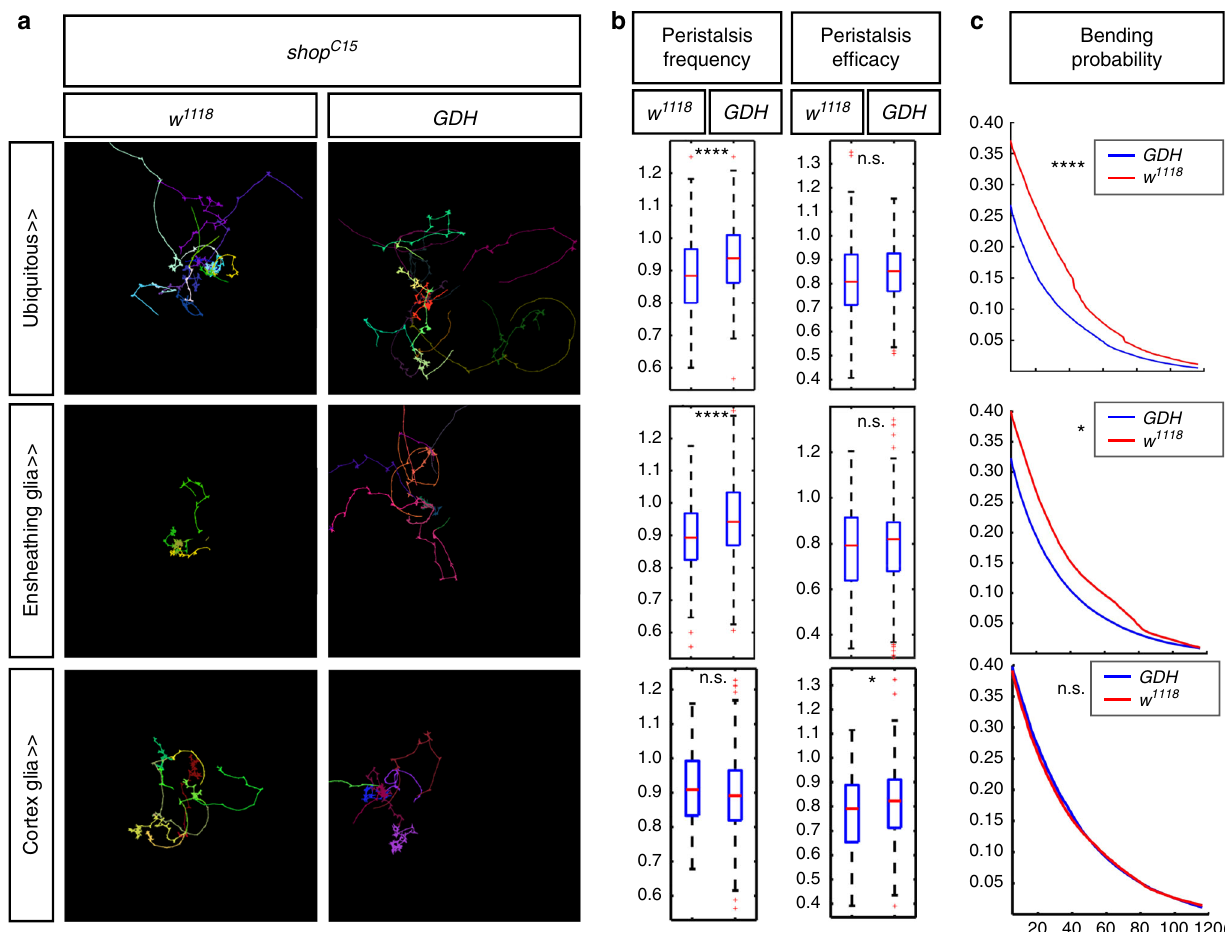
Fig. 7 Increased Gdh expression suppresses the shopper mutant phenotype. a Locomotion trajectories of third-instar larvae mutant for shopper ( shop C15 ) expressing Gdh ( Gdh ), either by presence of the ubiquitous driver ( da-Gal4 ), an ensheathing glia-speci fi c driver ( R83E12-Gal4 ), or a cortex glia-speci fi c driver ( R55B12-Gal4 ) (on the right) are compared to controls that contain the mutation as well as drivers but no Gdh expression transgene ( w 1118 ) (on the left). Expression of Gdh is mediated by an UAS-carrying P-element insertion into the Gdh locus. Upon ubiquitous and ensheathing glial cell-speci fi c expression of Gdh the locomotion is normalized, while no rescue of the locomotion phenotype associated with the shopper C15 mutant is seen upon expression in cortex glia. b Quanti fi cation of peristalsis frequency and peristalsis ef fi cacy. The peristalsis frequency is elevated when Gdh is expressed ubiquitously, whereas the peristalsis ef fi cacy can only be slightly elevated from expression in all cell types. c Quanti fi cation of bending probability. Note the rescue of the bending probability upon ubiquitous and ensheathing glial expression of Gdh (the red line indicates the shop C15 mutants, the blue line indicates the shop C15 mutants expressing Gdh ). Upon expression of Gdh in astrocytes, no rescue is noted and bending probability in both genotypes is identical. Box plots represent the fi rst and third quartile, as well as the median. Whiskers contain values within 1.5 times of the interquartile range, outliers are marked as red crosses, * p < 0.05, **** p < 0.001, n.s.: not signi fi cant, Wilcoxon rank-sum test. Due to space limitation please fi nd detailed statistical data